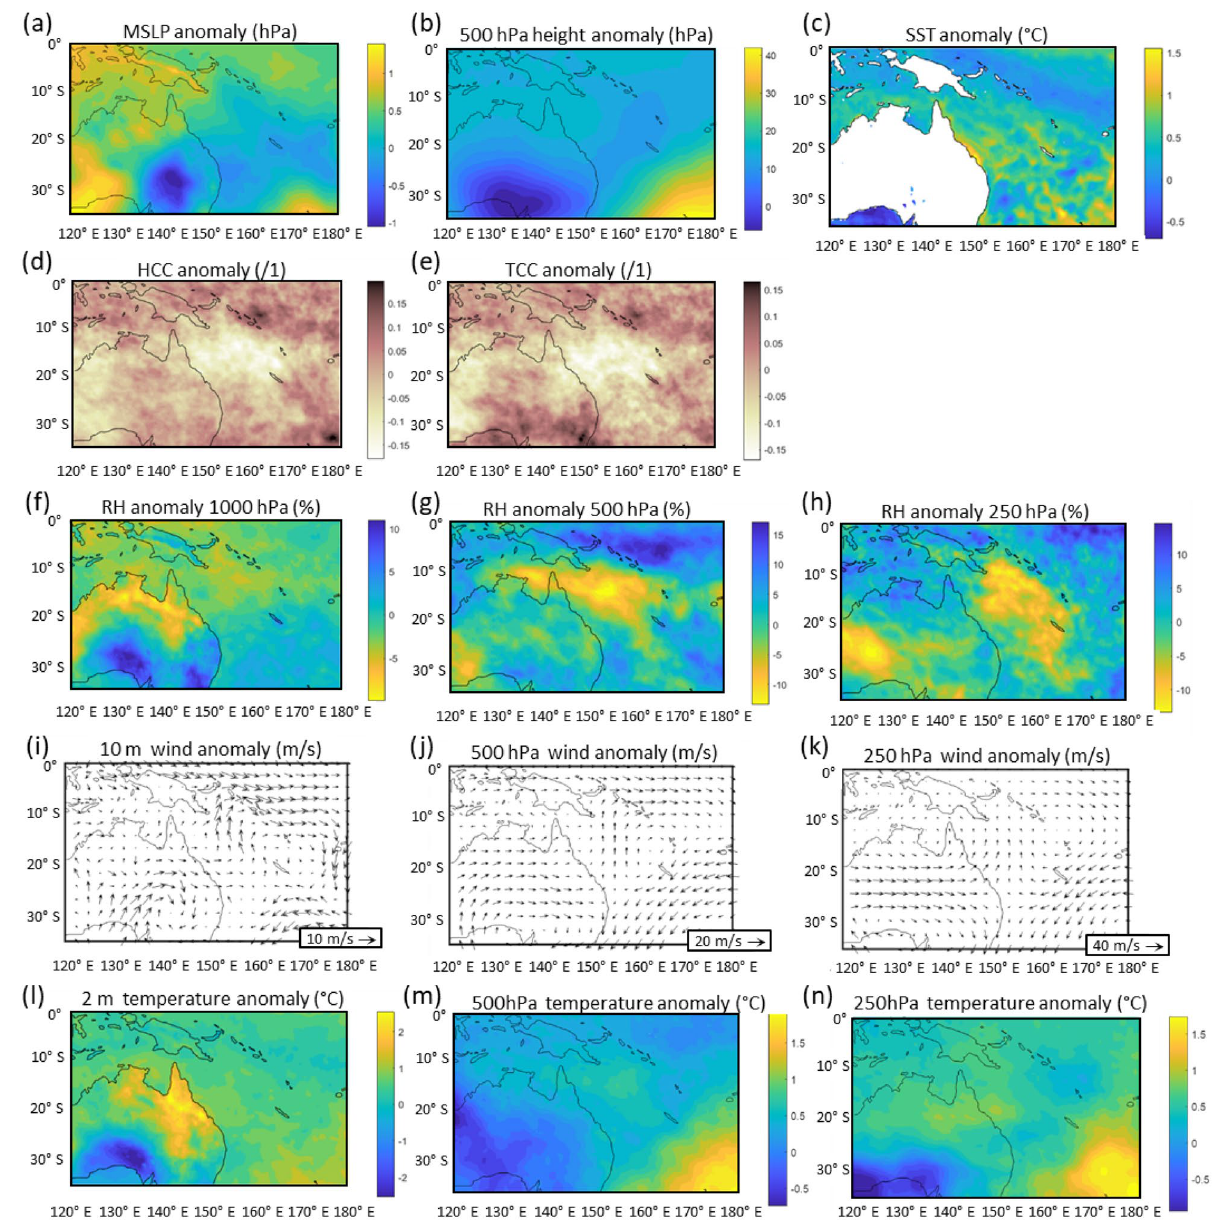
Figure 3. Anomalous atmospheric conditions over northern Australian and the GBR during the NDJ 2021–22 summer La Niña when compared to mean NDJ summer La Niña conditions (1980–2020). Mean Sea Level Pressure ( a ); 500 hPa height ( b ); Sea Surface Temperature ( c ); High cloud cover > ~ 500 hPa ( d ); Total cloud cover surface to ~ 500 hPa ( e ); Relative humidity at 1000 hPa, 500 hPa and 250 hPa ( f – h ); Wind at 10 m, 500 hPa and 250 hPa ( I – k ); Temperature at 2 m, 500 hPa and 250 hPa ( I – n